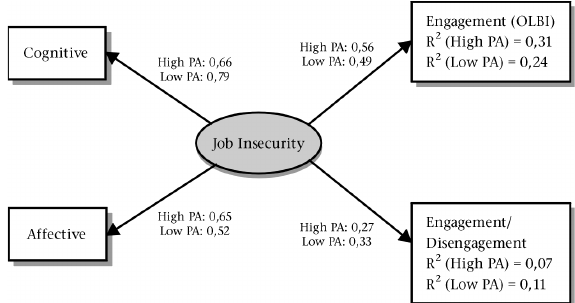
Figure 2: Structural model of job insecurity, burnout and work engagement of low and high positive affectivity (PA)